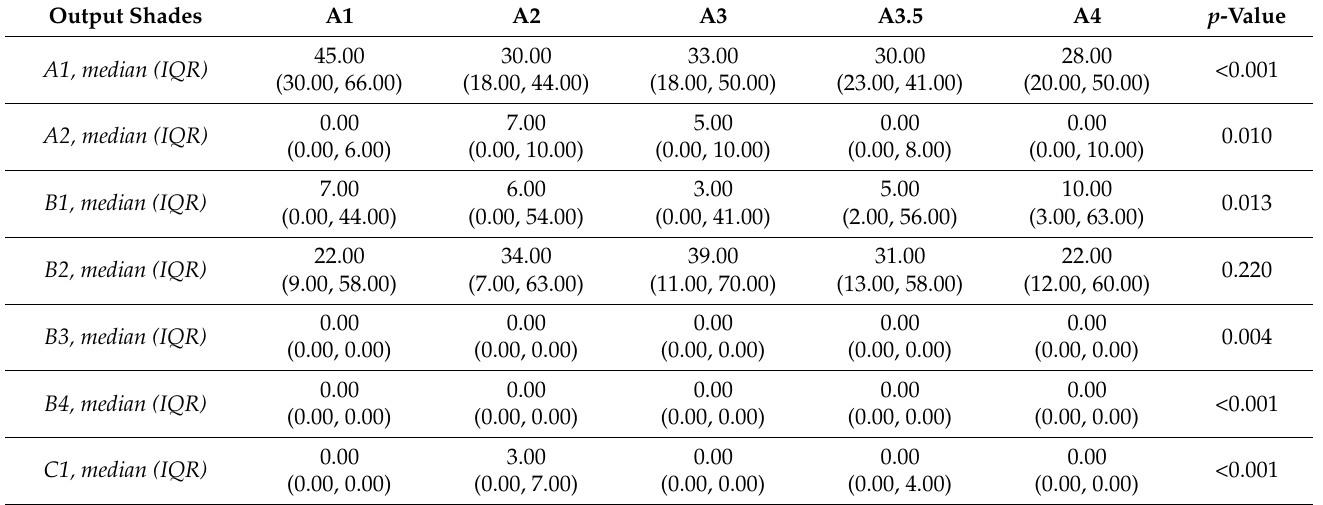
Table 2. Distribution of the % of output shades according to background shade. The table shows the results of the Kruskal–Wallis test for multiple comparisons of non-parametric